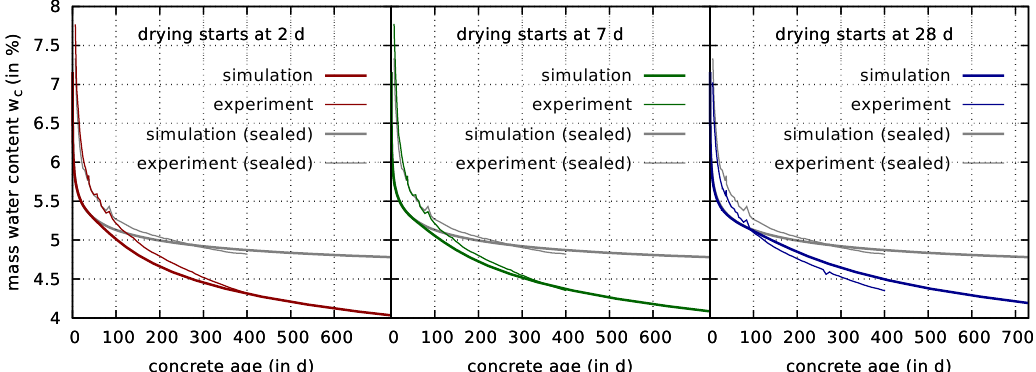
Figure 9. Comparison of measured [7] and computed evolutions of the mass water content in sealed (cf. Figure 6(right)) and in drying cylindrical specimens with drying started at concrete ages of 2 days ( left ), 7 days ( center ), and 28 days ( right ).